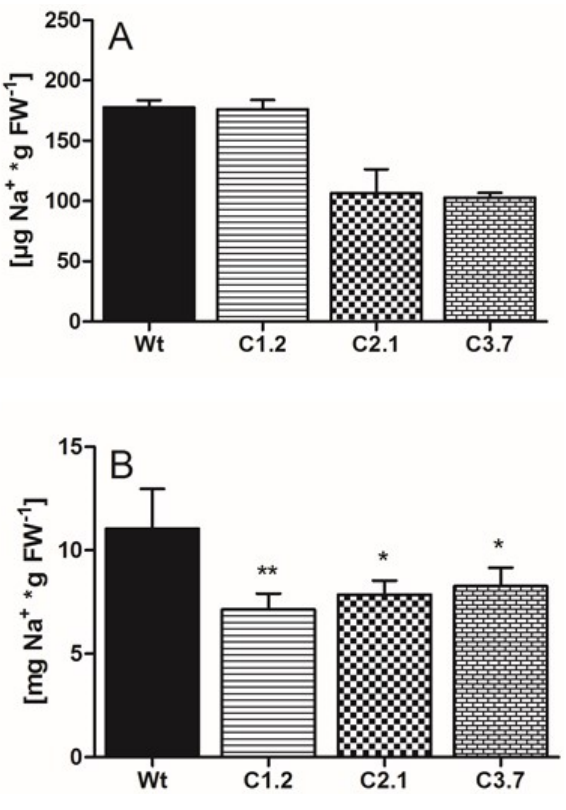
Figure 6. Sodium content in Wt and p35s::SOS1 c-term StrepII plants. Wt and p35s::SOS1 c-term StrepII plants were grown on soil for three weeks prior to transfer to long-day conditions. For the following two weeks, plants were treated with the same volume of either 150 mM NaCl solution or tap water every three days. Samples for ion quantification were taken after an additional two weeks. Na + concentrations in leaves under control ( A ) and under salt stress conditions ( B ), quantified by Ion chromatography. Values represent the mean of 3 biological replicates, each with 2 technical replicates. Error bars are ± SE. Data with *, ** are significant from Wt at p < 0.05 or p < 0.01 (two-way ANOVA).